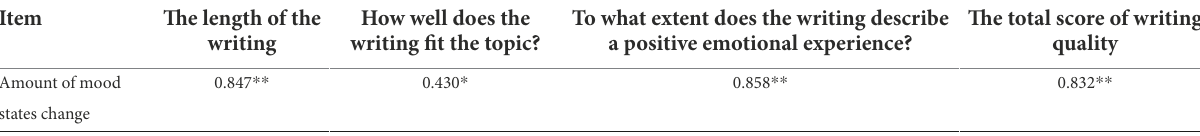
TABLE 5 Correlation analysis between writing quality and score change of BPMOS ( r ). Item